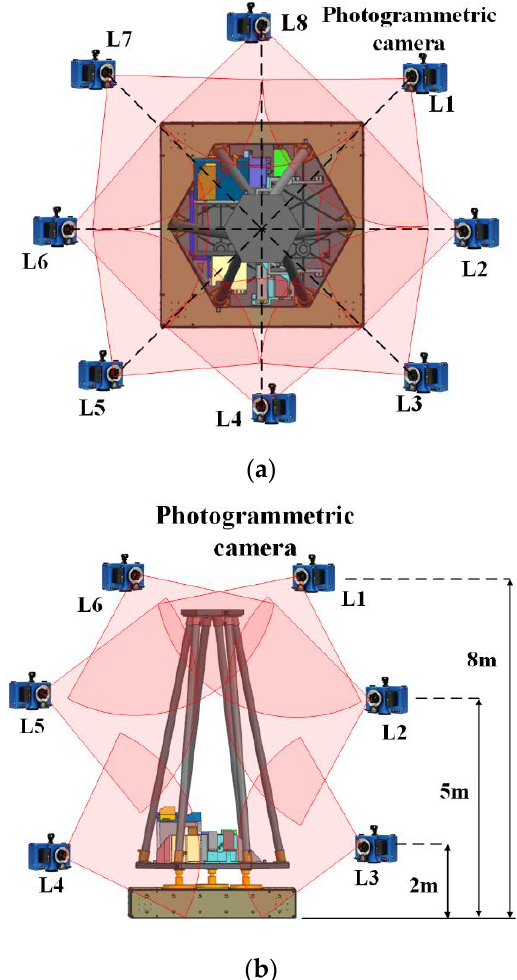
Figure 12. Diagram of the photogrammetric coordinate acquisition. ( a ) distribution of camera angle positions; ( b ) distribution of camera height positions.